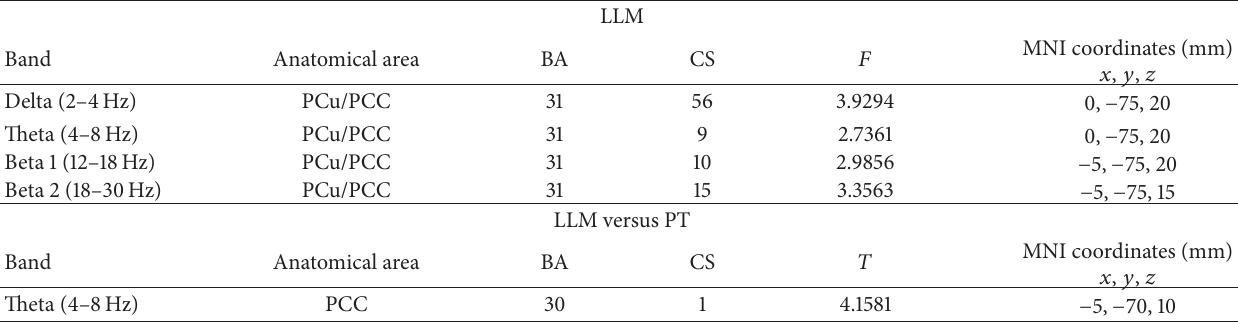
Table 2: EEG source maps at the differences at 𝑃 < 0.05 , corrected.